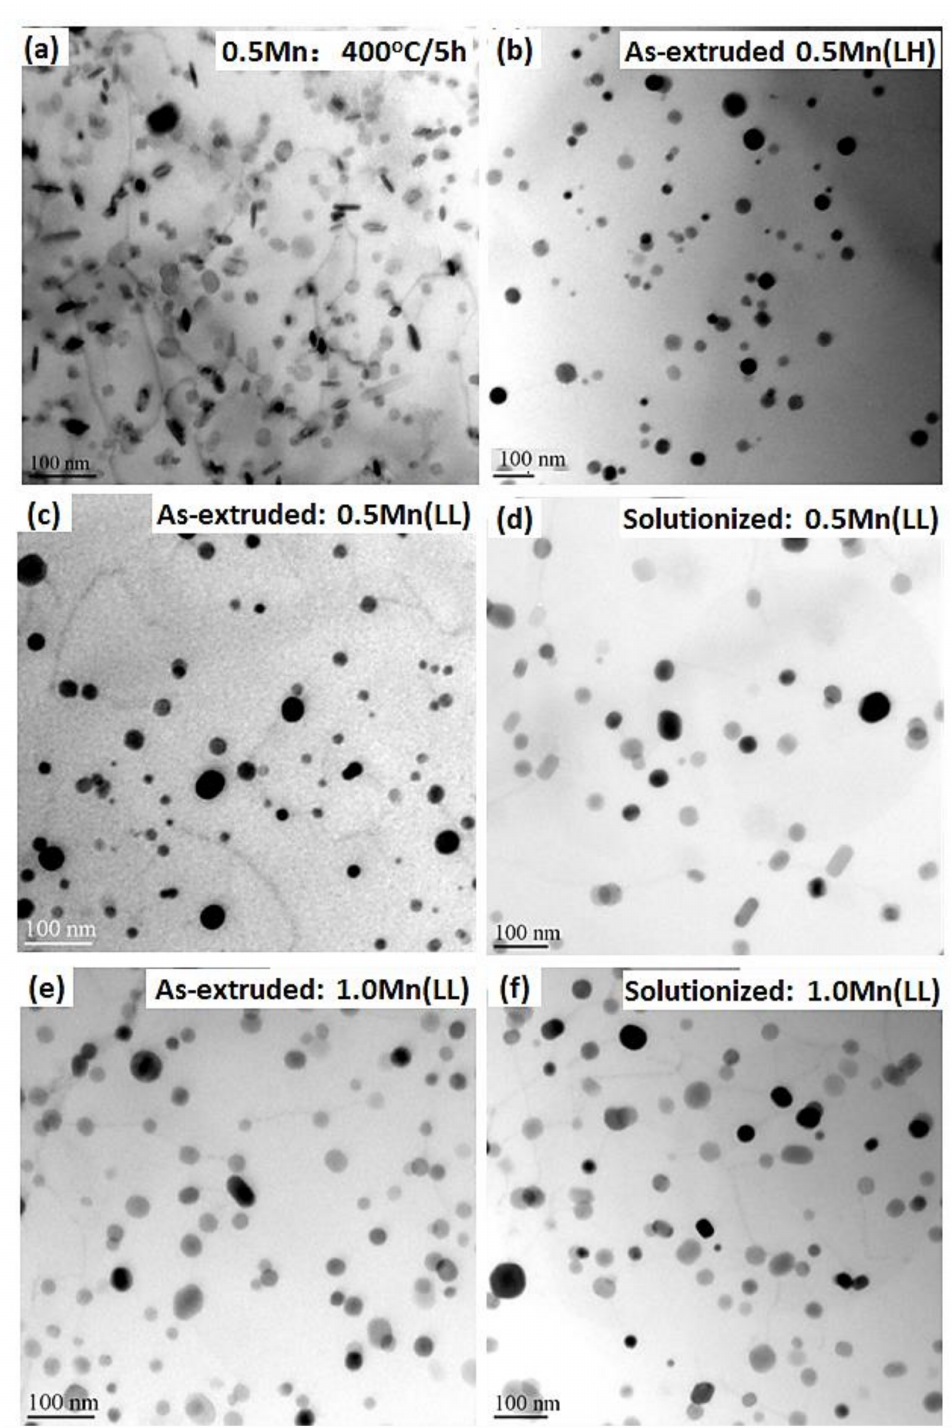
from the higher Mn content in 1Mn(LL).